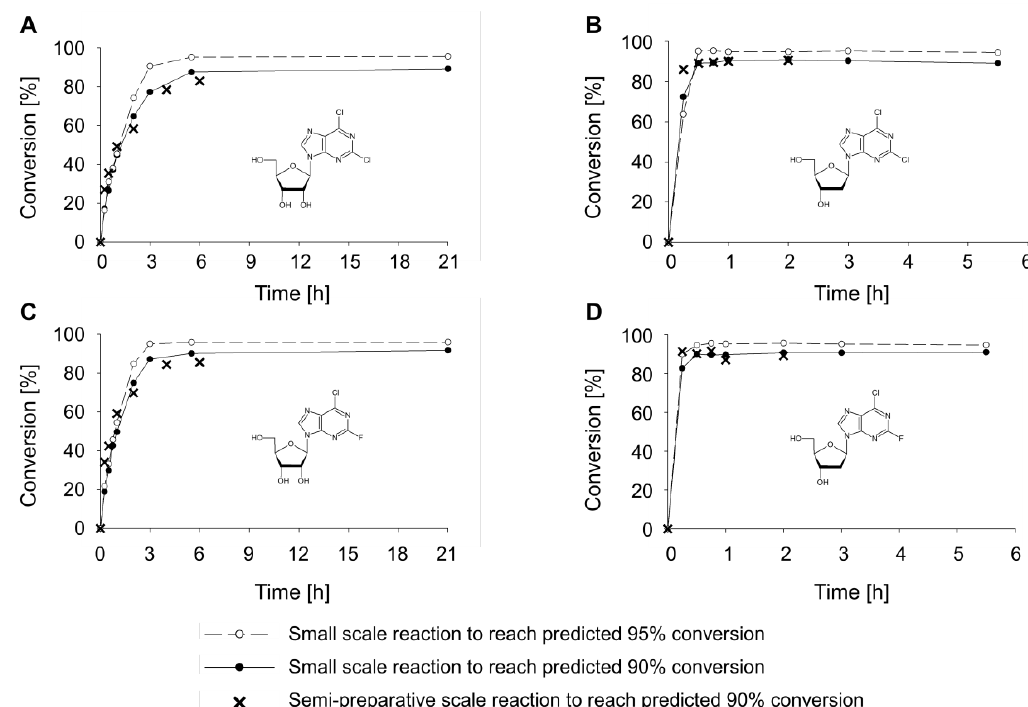
Figure 1. Synthesis of 3a ( A ), 3b ( B ), 3c ( C ), and 3d ( D ) in transglycosylation reactions at small and semi-preparative scale using thermostable nucleoside phosphosporylases PyNP 02 and PNP